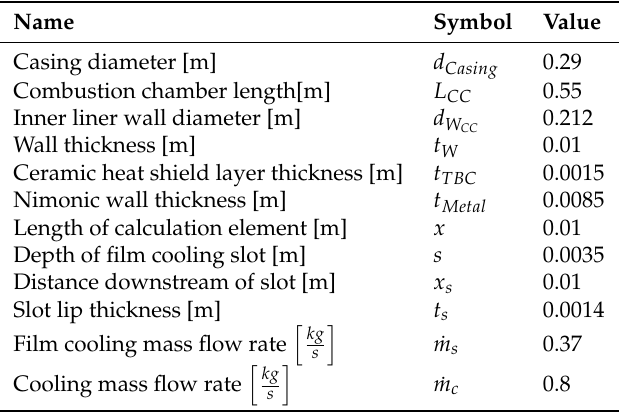
Table 5. Combustion chamber geometrical characteristics and film cooling parameters.